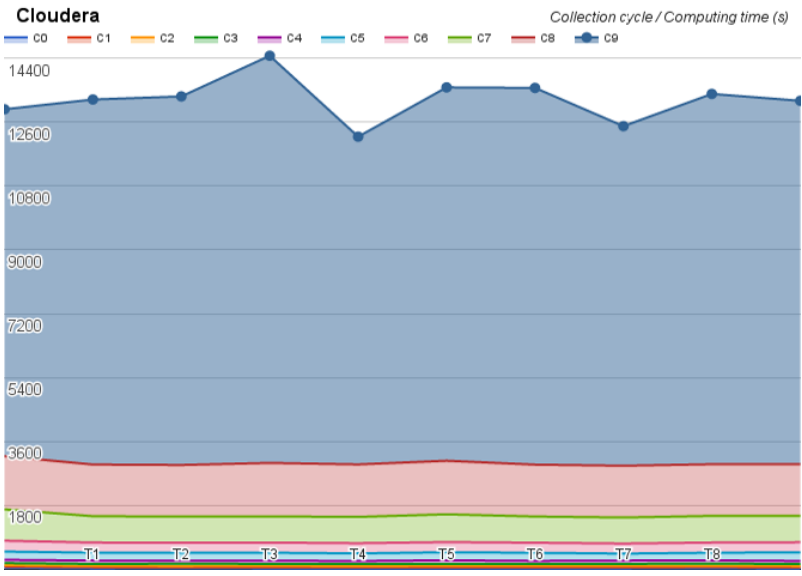
Figure 4. Cloudera benchmark time (seconds) distribution.